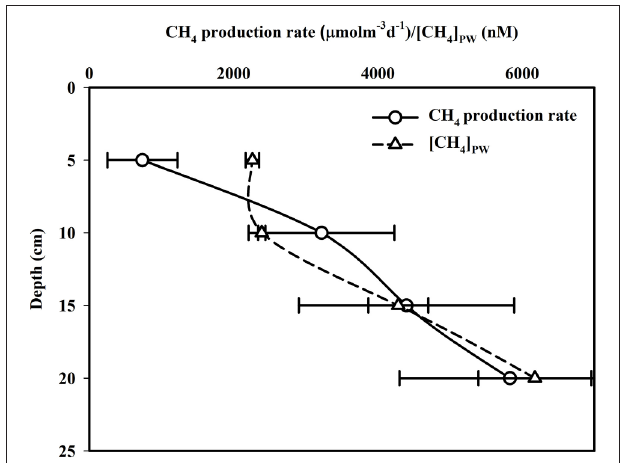
FIGURE 4 | Vertical distributions of CH 4 production rates and pore water CH 4 concentrations at intertidal mangrove sediment.